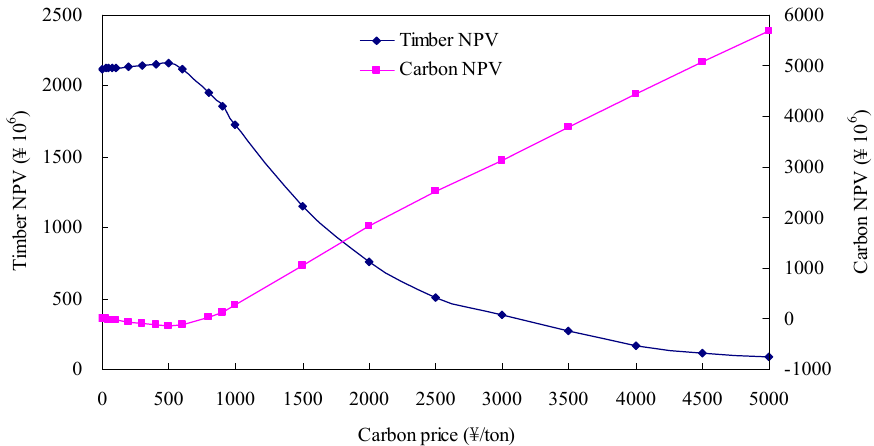
Figure 2. Developments of the discounted net present values of harvested timber and the DoC together with carbon prices that varied from zero to 5000 ¥/ton, where DoC represents the differences of carbon stocks in living tree biomass between the beginning and the end of the planning horizon.